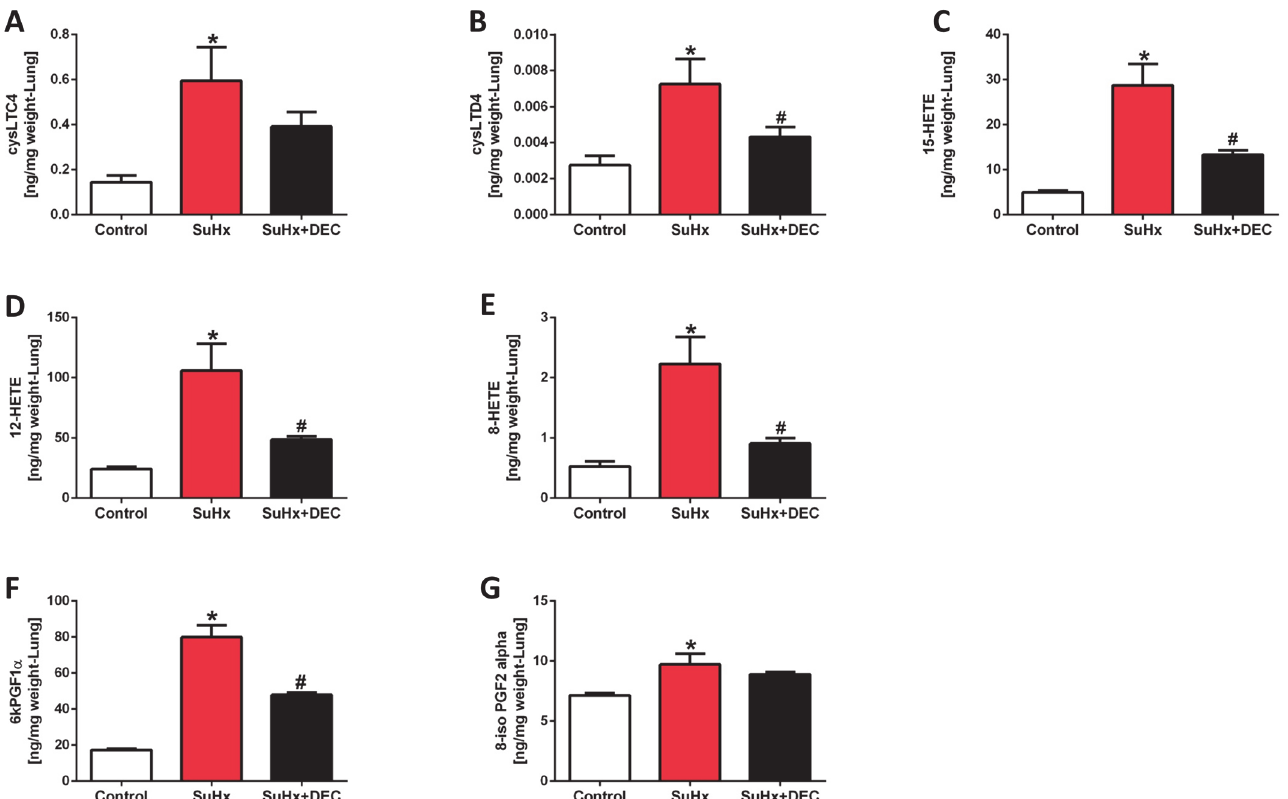
Fig 7. Diethylcarbamazine treatment reduced the increment in lung tissue eicosanoids. Shown are the data obtained from normal control rats, animals treated with SU5416 and exposed to hypoxia for 4 weeks (SuHx) (n = 4) and animals concomitantly treated with diethylcarbamazine (DEC) (n = 6). DEC treatment blunted the increase of LTC4, LTD4, 8, 12, and 15 HETE. In addition, DEC treatment also blunted the increase in 6-keto PGF1 α (The stable prostacyclin metabolite) but not the increase in tissue 8-iso PGF2 α . * P < 0.05 vs. control, #P < 0.05 vs.